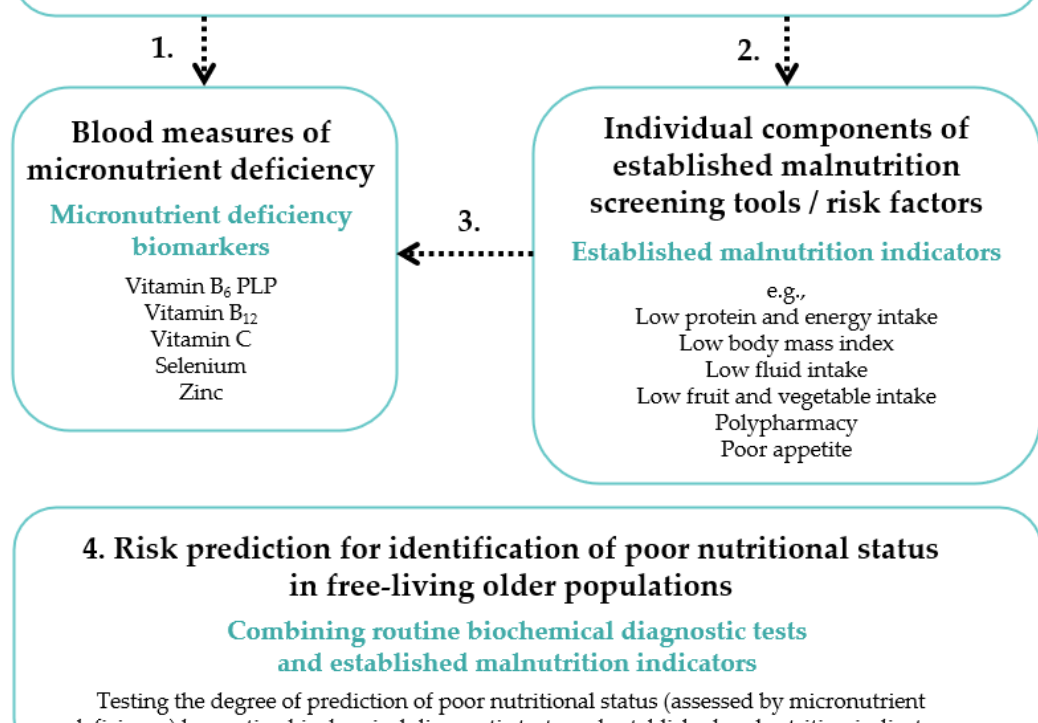
Figure 1. Schematic overview of the concepts used in the investigation of routinely measured diagnostic tests as potential predictors of poor nutritional status/malnutrition risk in free-living older populations. For analyses, a poor nutritional status was defined as the presence of ≥1 micronutrient deficiency. Stage 1: Micronutrient deficiency biomarkers used as validation for routine biochemical diagnostic tests used in primary and clinical care. Stage 2: Individual components of established malnutrition screening tools/risk factors (established malnutrition indicators) used as further validation for routine biochemical diagnostic tests. Stage 3: Micronutrient deficiency biomarkers used as validation for established malnutrition indicators. Stage 4: Routine biochemical diagnostic tests as potential predictors of poor nutritional status risk in free-living older